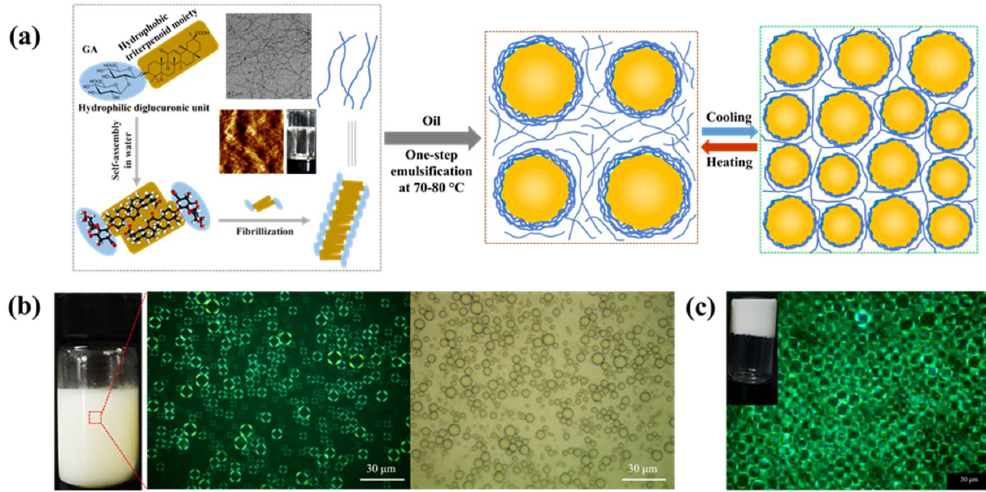
Figure 2. ( a ) Schematic illustration of the fibrillar self-assembly of glycyrrhizic acid (GA) molecules in water, forming GA nanofibrils and hydrogels, and of the formation of thermoresponsive gel emulsions by the multilayer adsorption of GA nanofibrils at the oil–water interface and the assembly of fibrillar hydrogel network in the continuous phase after cooling. ( b ) PLM (left) and optical microscopy (right) images of the reconstituted emulsions with 0.25 wt% GA nanofibrils from the gel emulsions stabilized by 4 wt% GA nanofibrils. The radiant halo with a Maltese cross in PLM image reveals the multilayer fibril shell structure of the droplets. ( c ) Photograph and PLM image of the gel emulsion with 60 wt% olive oil prepared using 4 wt% GA nanofibrils. Images were reproduced with permission from [33].